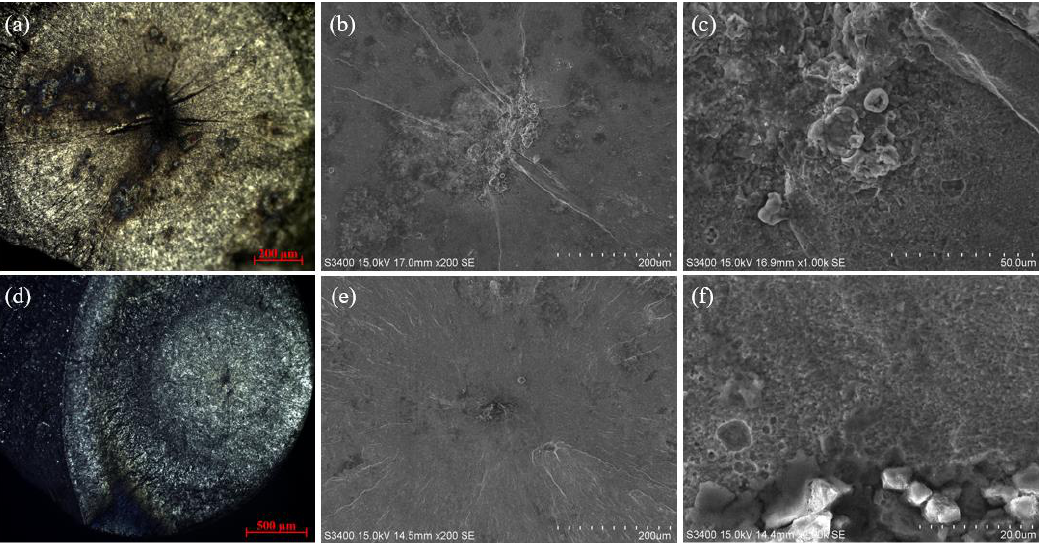
Figure 6. Fracture morphology of crack initiation zone: ( a – c ) base metal specimen at σ a = 645 MPa, ( d – f ) welded joint specimen at σ a = 645 MPa.